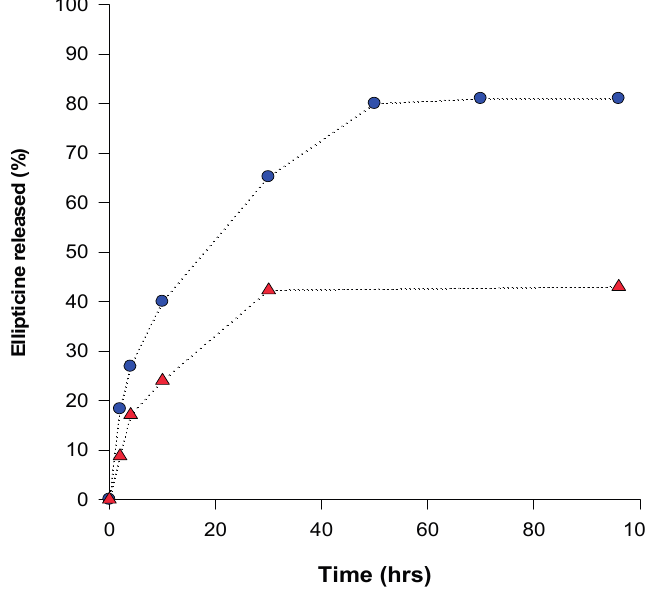
Figure 2. Ellipticine release from ellipticine-micelles at pH 5.0 ( ● ) and 7.4 ( ▲ ). Values are given as means of two parallel